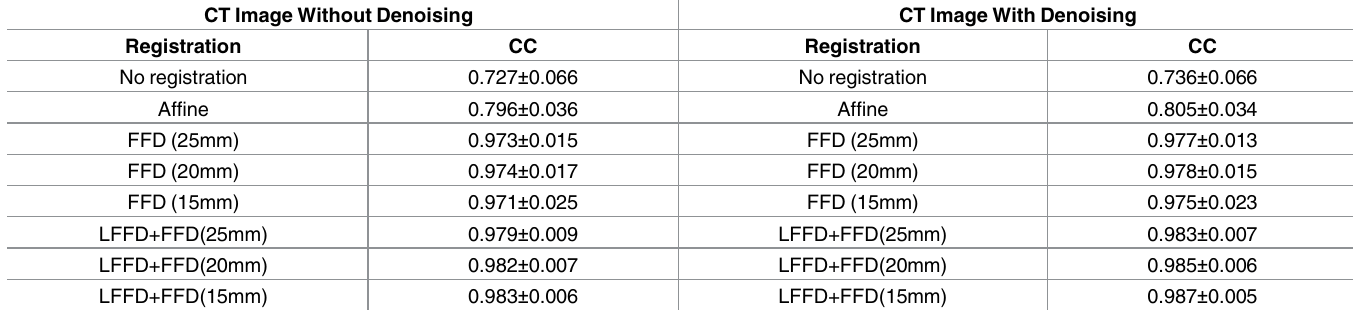
Table 1. Comparison of the averageregistration errors for 11 sets of clinical data in terms of the CC for different registration strategies. CT Image Without Denoising